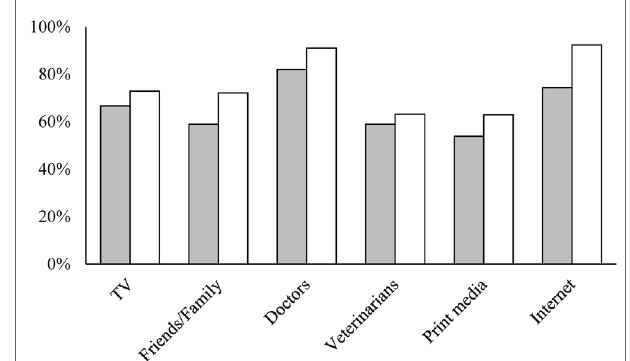
FigUre 2 | Proportion of respondents discontinuing or decreasing dog and cat contact during or after pregnancy. Gray bars are for dog contact and white bars are for cat contact.